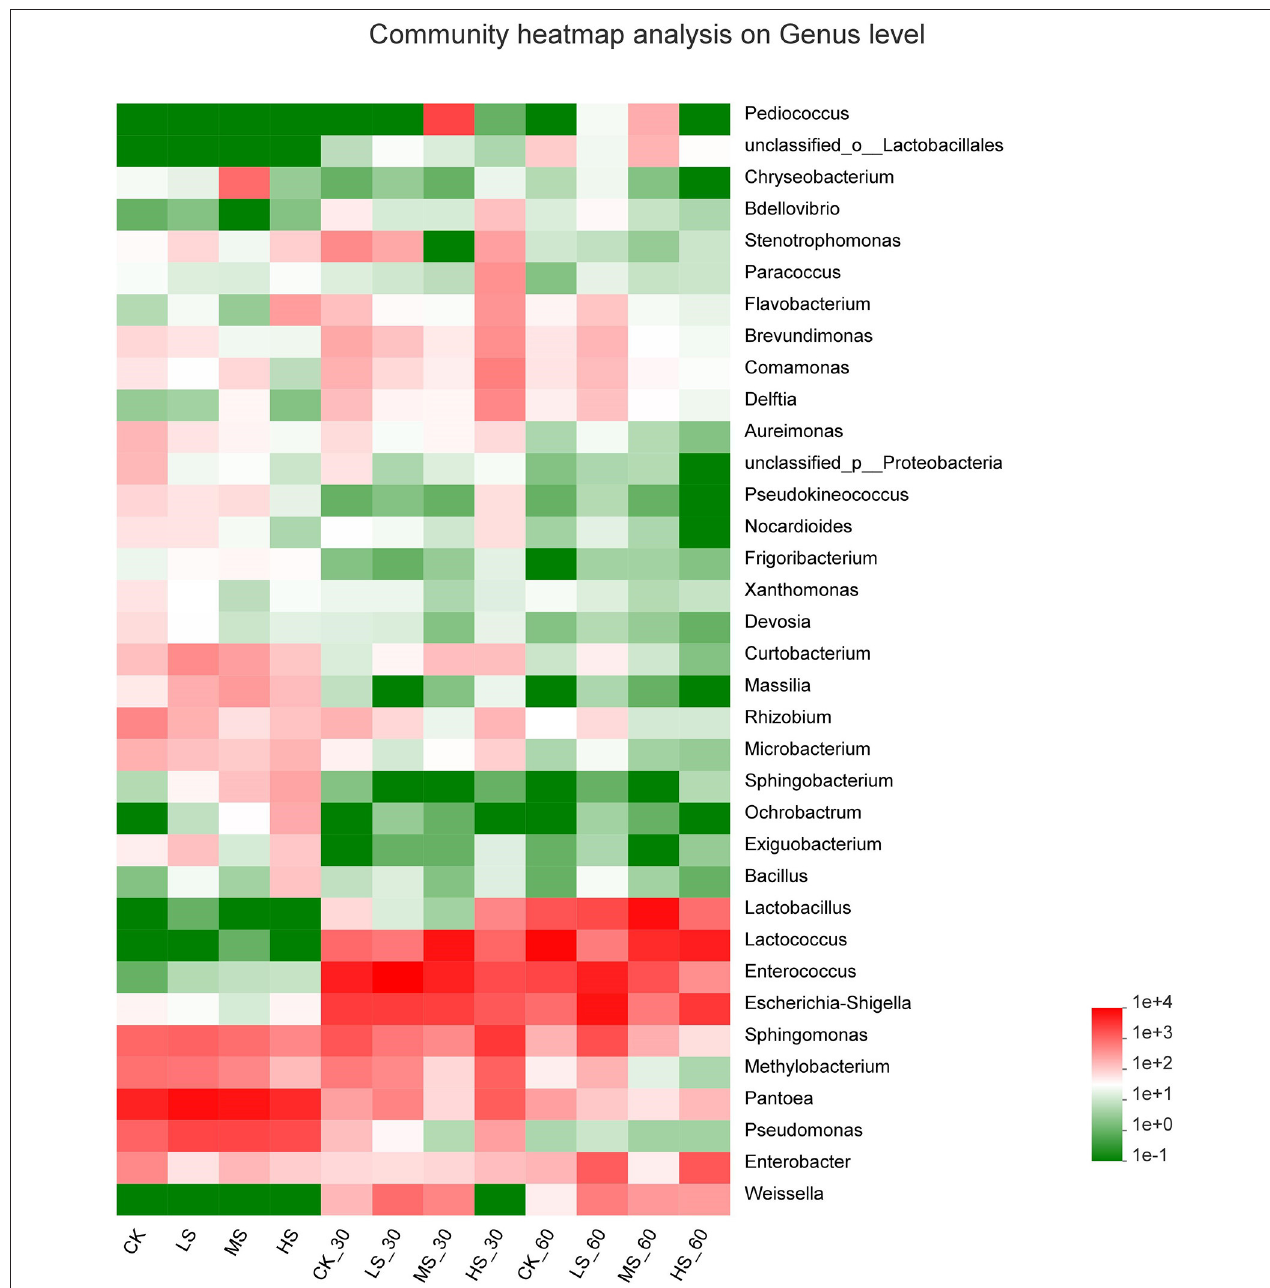
FIGURE 3 | Heatmap of prominent bacterial genera (35 most abundant genera) for alfalfa silage. CK, fresh material of alfalfa without salt stress; LS, alfalfa under light salt stress; MS, alfalfa under moderate salt stress; HS, alfalfa under severe salt stress; 30, 30 days of ensiling; 60, 60 days of